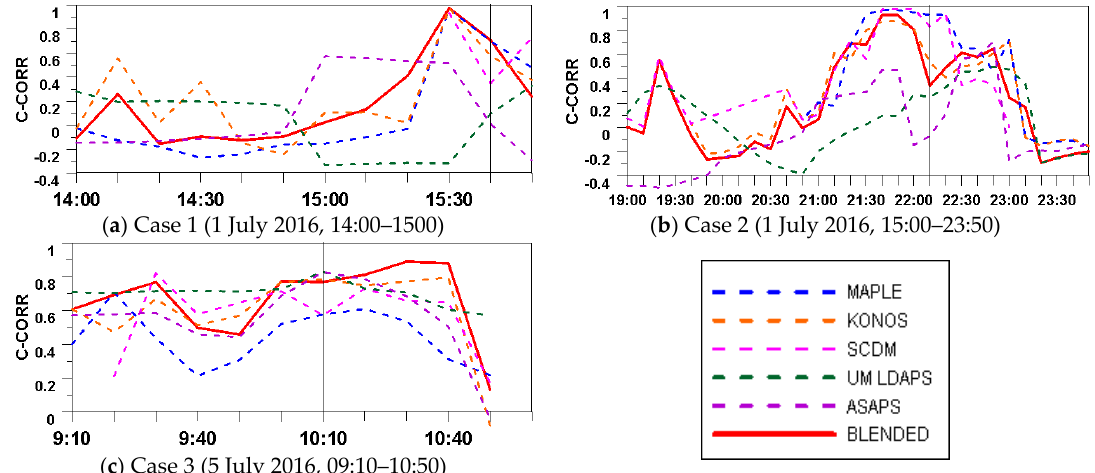
Figure 6. Accuracy evaluations (by correlation coefficient) for real-time QPF produced by the five tested models and the blended approach for all three cases. Grey line marks peak actual precipitation.